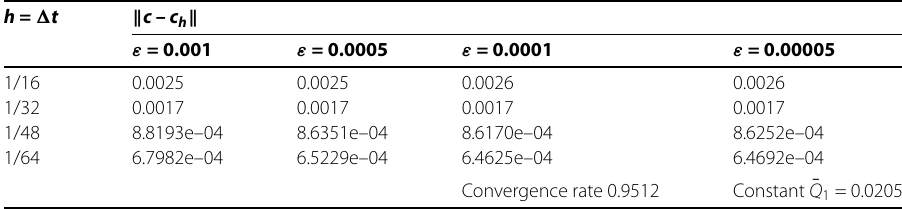
Table 1 The convergence rate for (cid:2) c – c h (cid:2) in the two-dimensional case